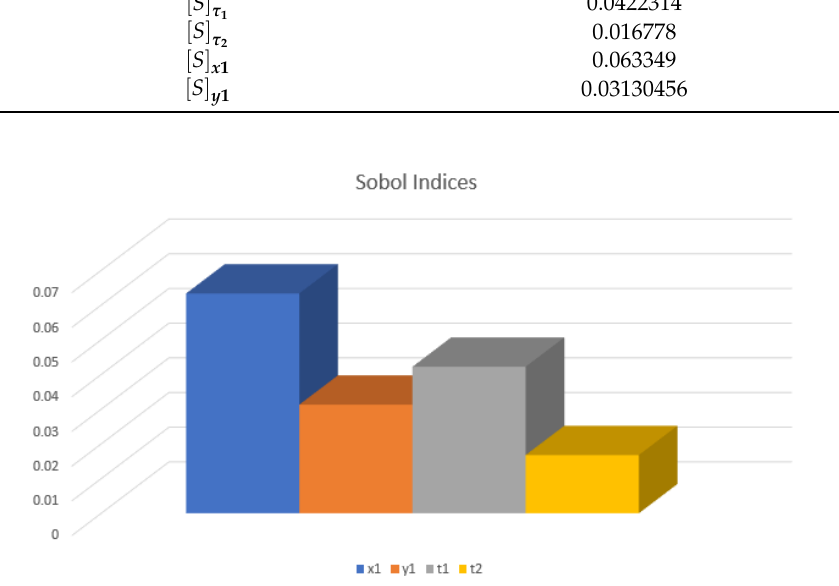
Figure 8. Graphical representation of Sobol Index value for each model parameter.